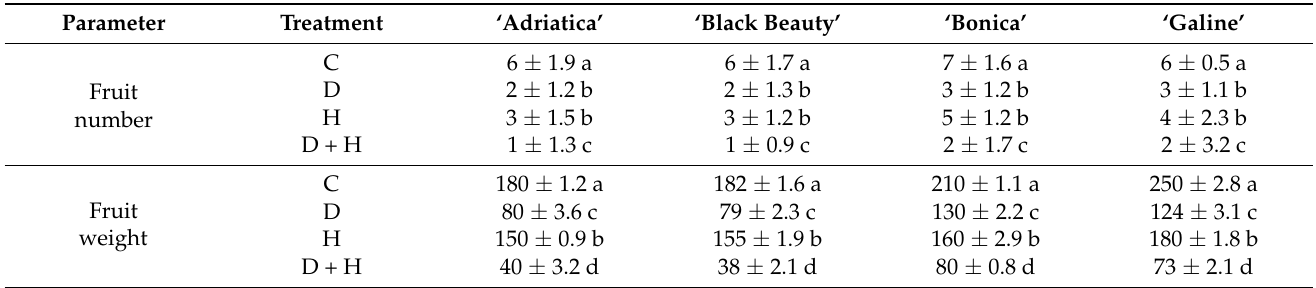
Table 2. Yield attributes of four eggplant cultivars exposed to drought, heat, and drought + heat stresses harvested 40 days after